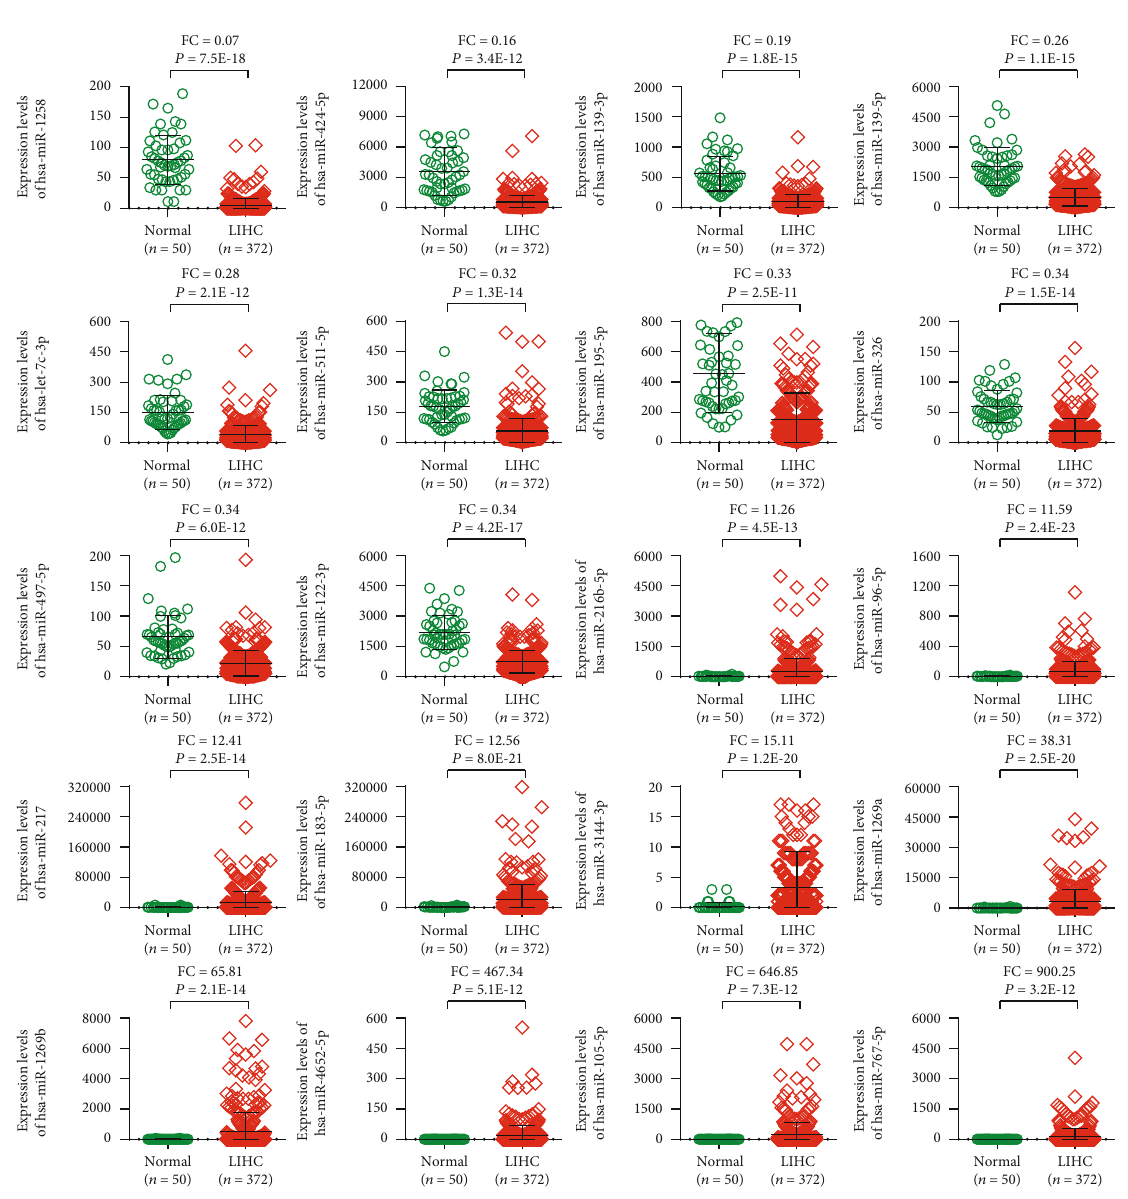
Figure 2: The expression level of top 20 DEGs in HCC. The genes meet the criteria of foldchange ð FC Þ ≥ 2 or ≤ 0.5 with p value < 1.0 E